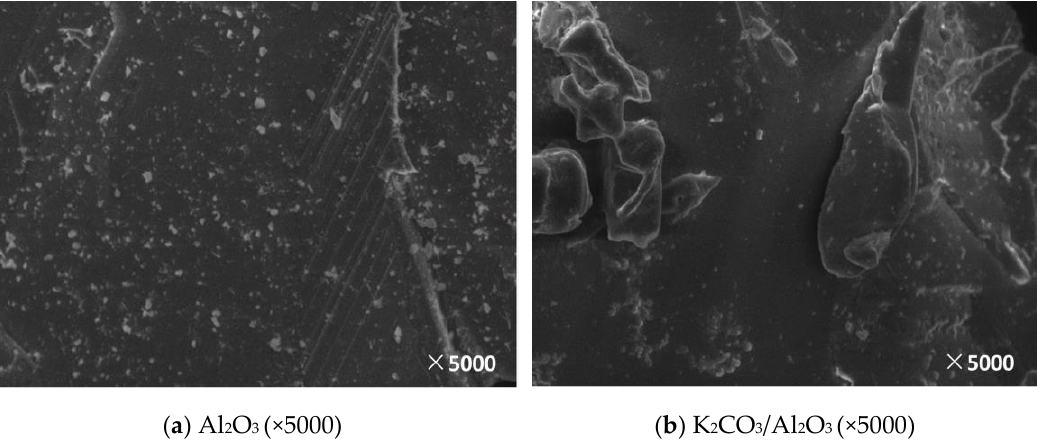
Figure 7. SEM image before and after Al 2 O 3 loading. ( a ): The SEM image of Al 2 O 3 ; ( b ): The SEM image of K 2 CO 3 /Al 2 O 3 .